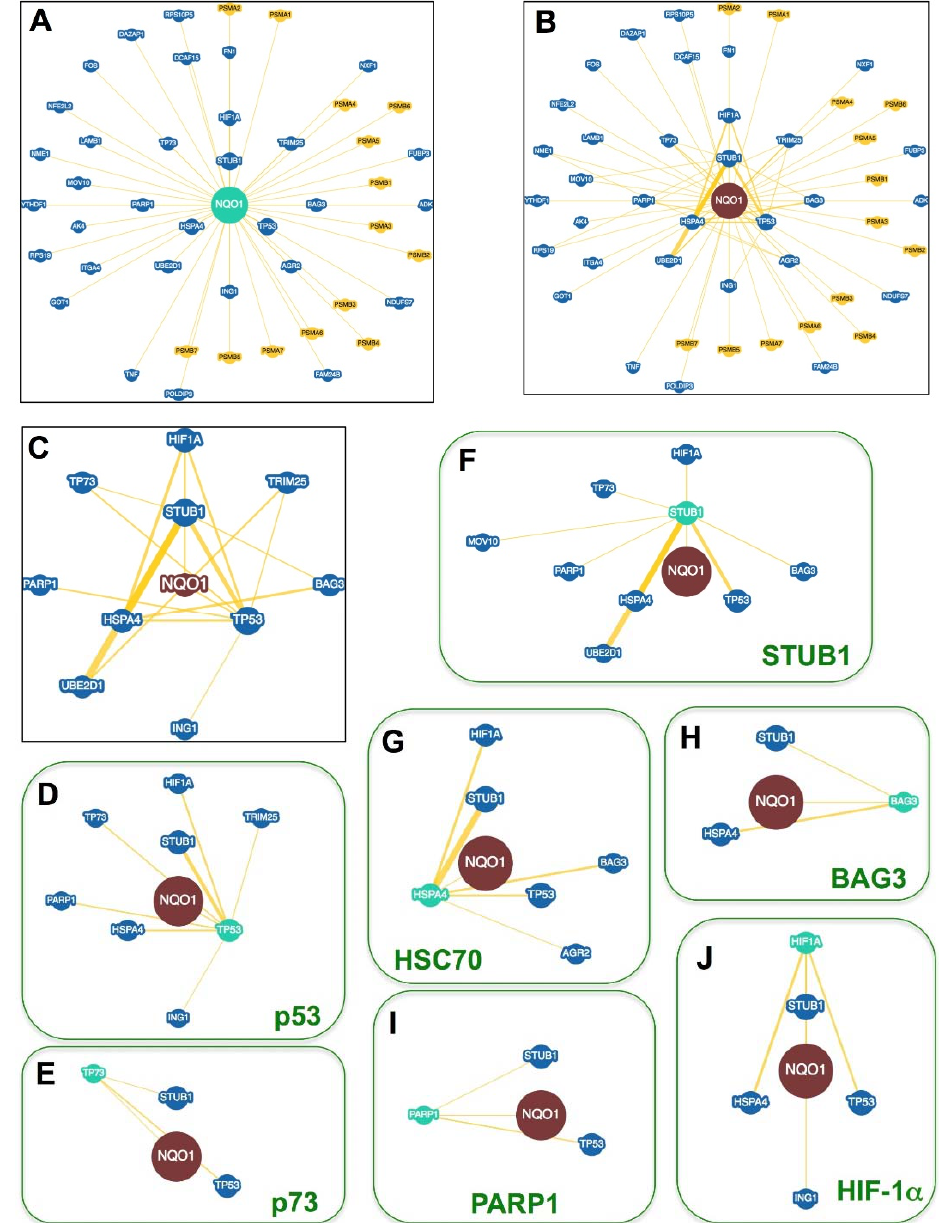
Figure 4. The NQO1 interactome. ( A ) NQO1 protein partners described in at least one report. ( B ) Connectivity between NQO1 partners. The shorter the radial distance between a partner and NQO1 indicates a higher interconnectivity. Partners in yellow are from mouse and in blue from human. ( C ) A zoom from panel ( B ) shows the most highly interconnected partners of NQO1. ( D – J ) Interactions between NQO1 partners in panel ( C ) and other proteins to highlight their different interconnectivity. The thickness of connecting yellow lines is related to the number of reports describing the interaction. Data were retrieved from the BioGRID database (https://thebiogrid.org/108072, accessed on 1 April 2022) [111].